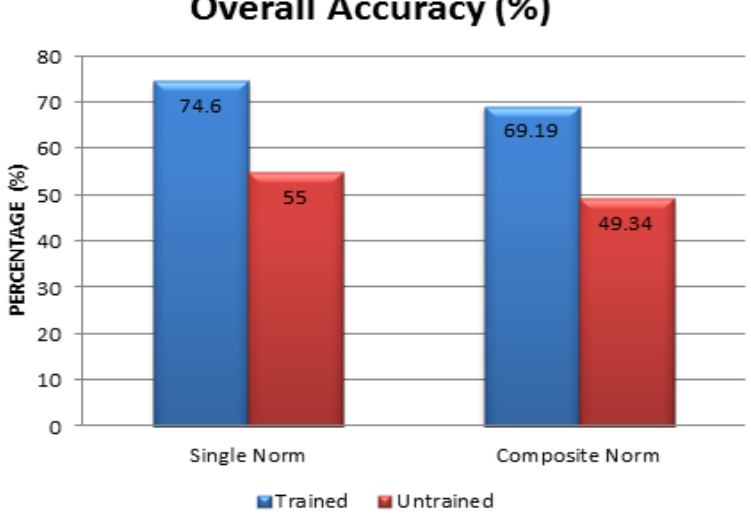
Figure 9. Details of accuracy assessment in trained and untrained case of classification results for Landsat-8 data with single and composite measure Landsat-8 data with single and composite measure respectively.